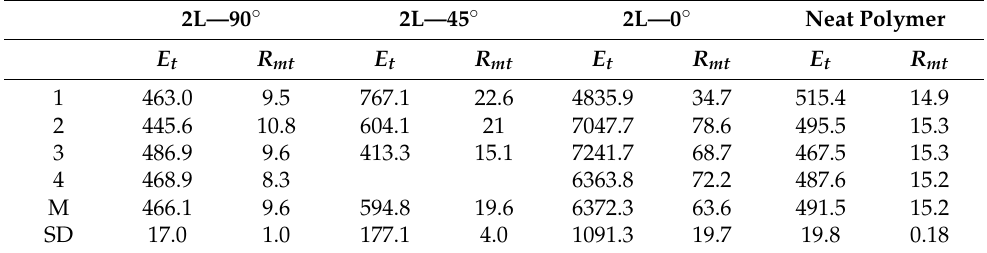
Table 4. Tensile modulus E f and tensile strength R mf of the four samples of double layer (2L) compos- ites cut in three directions with respect to fibers orientation, and of the neat polymer. All values are in MPa.